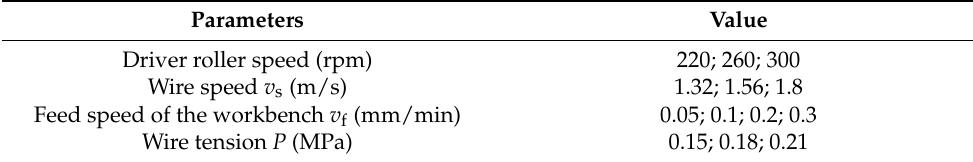
Table 3. Process parameters selection scheme.